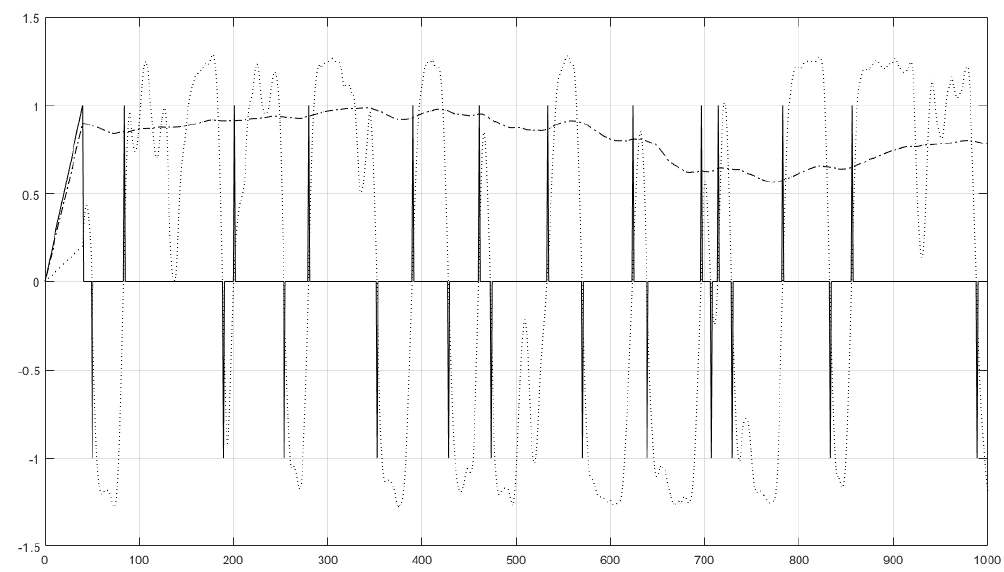
Figure 14. Example graphical output from function Backtester. The plot shows the post-filtered (for T = 10) AVR α σ [ n ] (dotted line), the pre-filtered time series u n (dot-dashed line) and z c [ n ] (solid line) which identifies the zero-crossings of α σ [ n ] . The plot is for the case when pre-filtering is undertaken for a look-back window size of W = 30 and post-filtering using a look-back window size of T = 10. The financial time series data used in this case is FTSE100 daily prices: